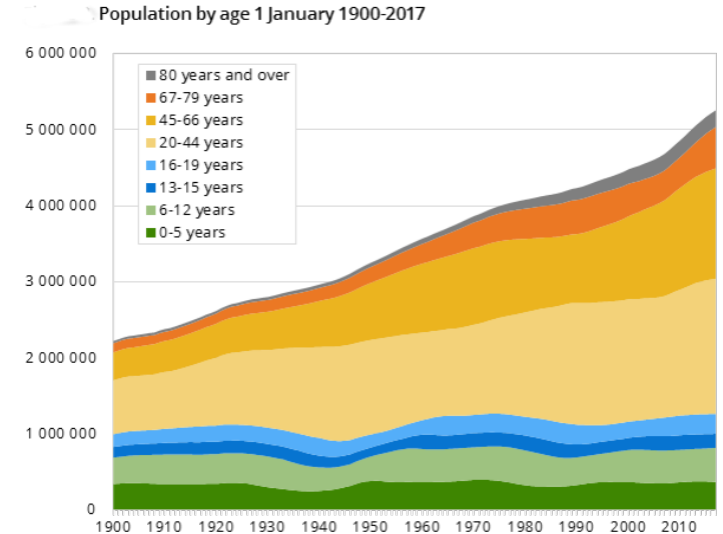
Figure 1. Statistics Norway